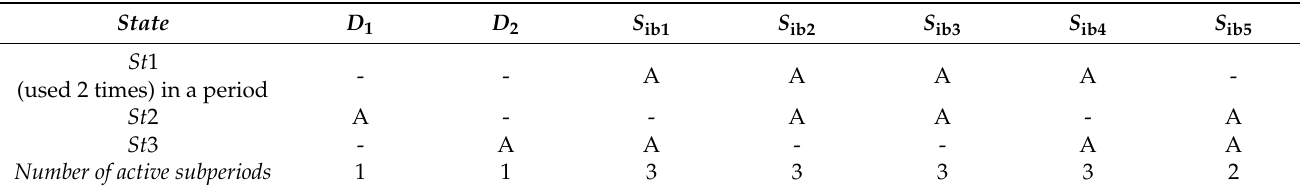
Table 2. Active switches (A) in subperiods of the AIVB’s